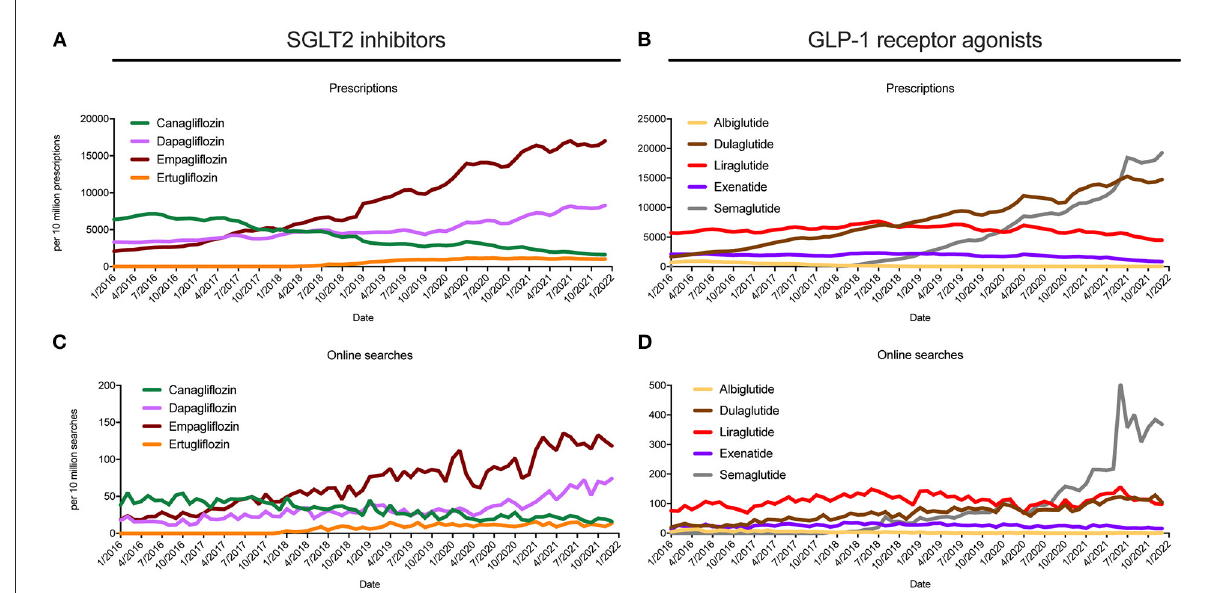
FIGURE2 Trends in prescriptions and online searches for SGLT2i and GLP-1 RA drug names between 2016 and 2021 for the United States. Prescription rates for selected (A) SGLT2i and (B) GLP-1 RA drug names as monthly prescriptions per 10 million prescriptions are shown. Trends in online searches for (C) SGLT2i and (D) GLP-1 RA are depicted as monthly query fraction per 10 million searches. All data are representative for the United Sates between 2016 and